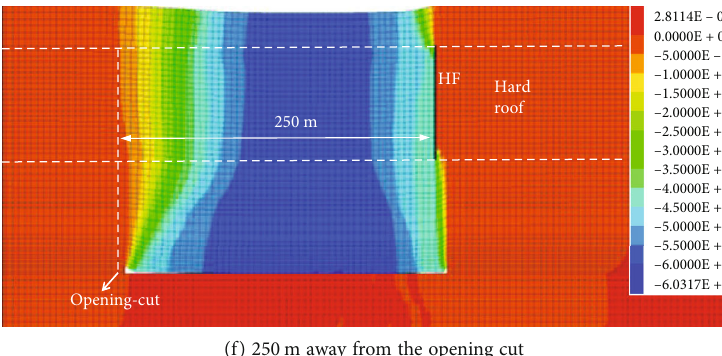
Figure 15: The vertical displacement nephogram when the THR reaches the fi rst breaking span under di ff erent fracturing